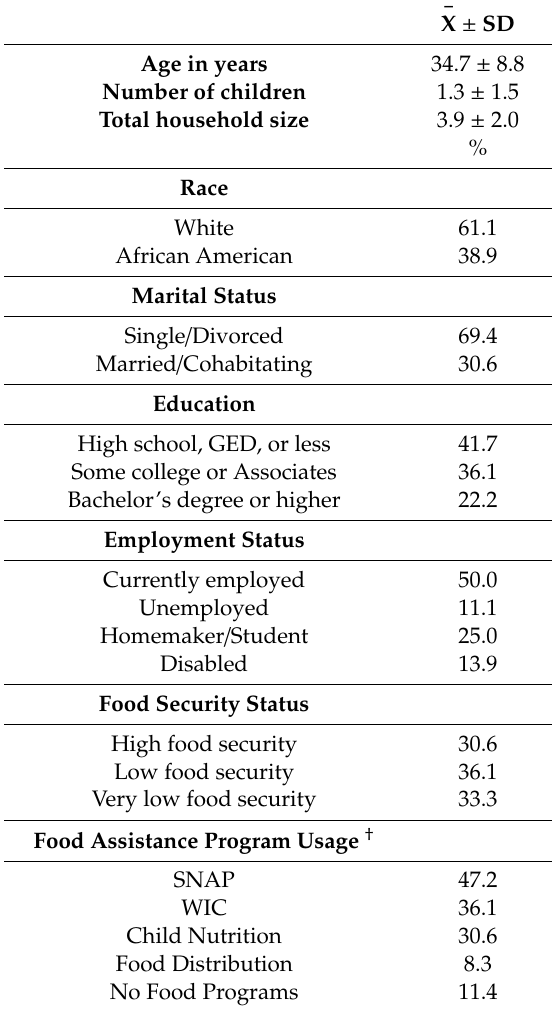
Table 1. Demographic and household characteristics of low-income Iowa women ( n =